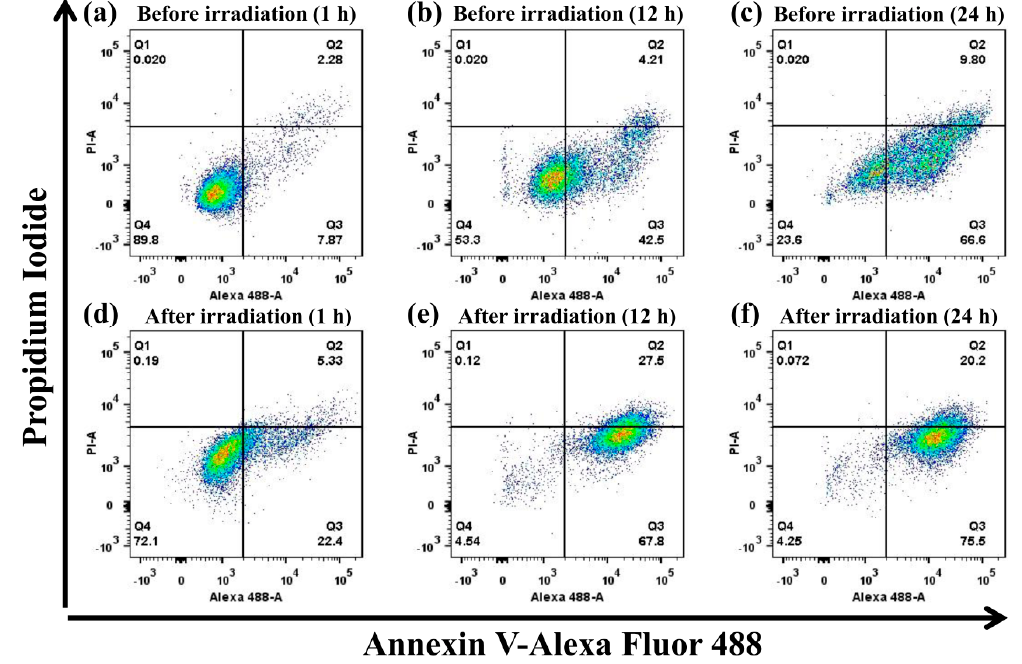
Figure 5. Flow cytometric analysis of the mechanisms of cell death induced by DOX/5-ALA-loaded A-PPG micelles in HeLa cells at 1, 12 and 24 h before irradiation ( a – c ) and after irradiation for 120 s ( d–f ). The numbers in the profiles indicate the percentages of cells in each quadrant.